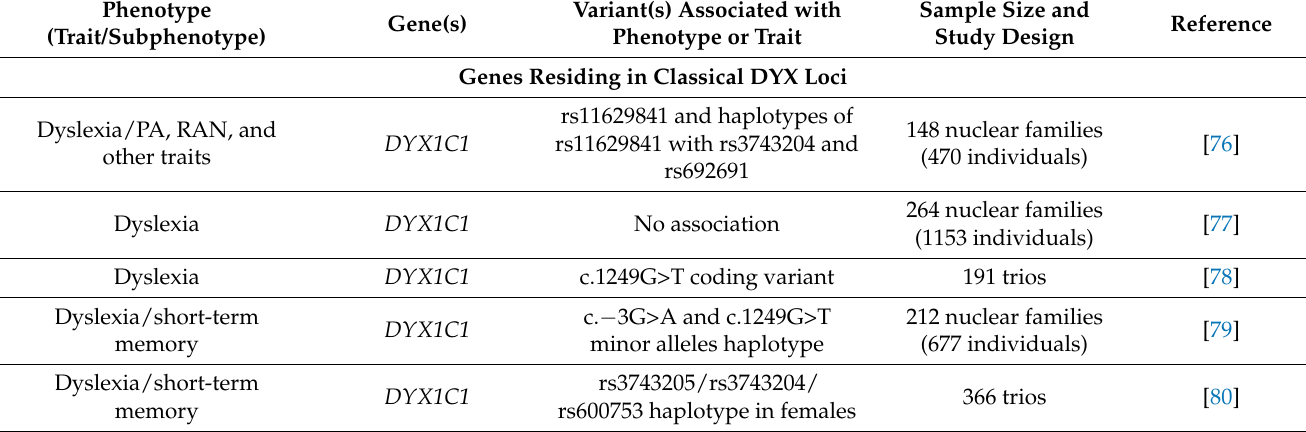
Table 2. Summary of association studies of established or candidate SLD/dyslexia